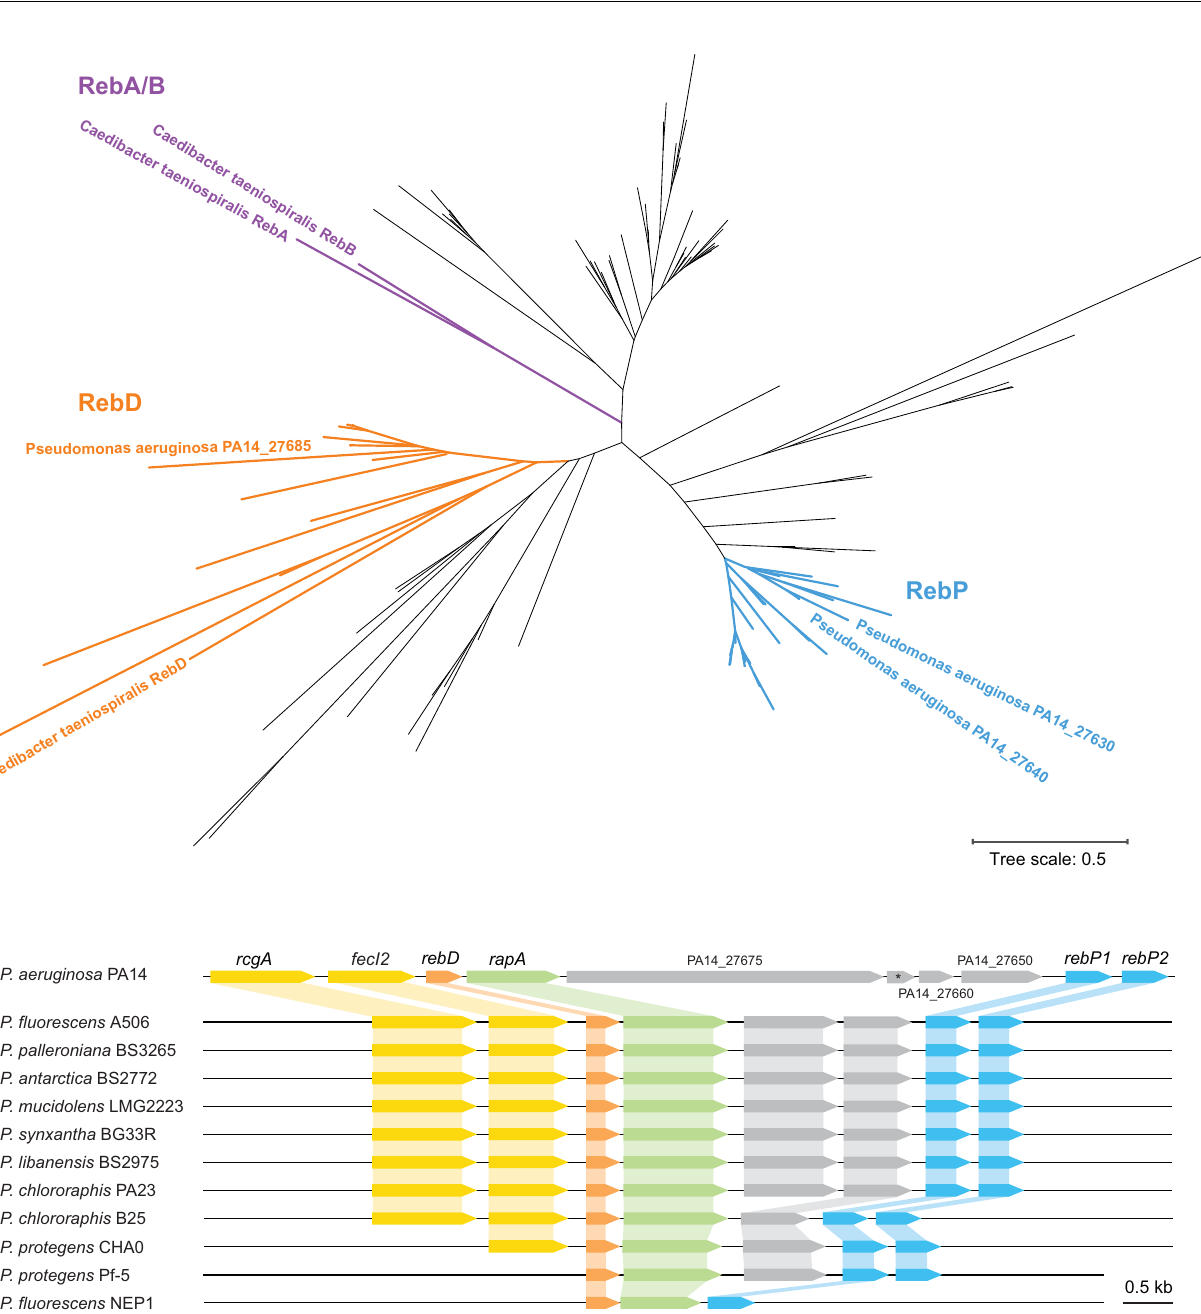
plemented strain ( Δ pel Δ rebP1P2 :: rebP1P2 ; average of 9.6 R-